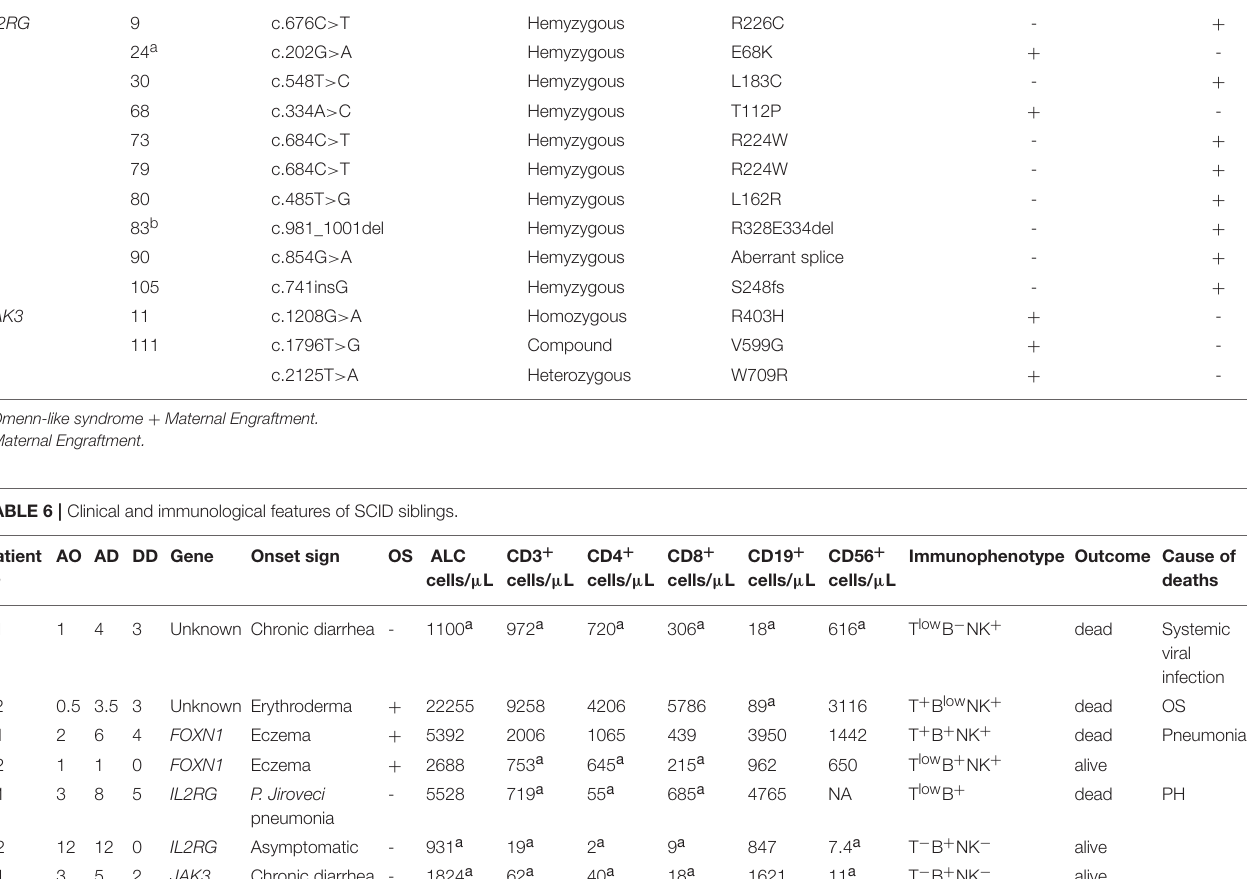
TABLE 5 | Genetic mutations in atypical SCID due to cytokine signaling disorders. Gene